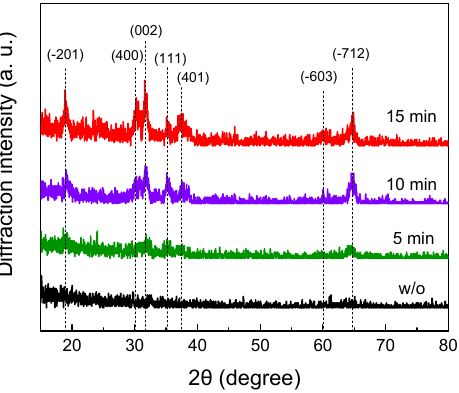
Figure 4. Grazing incidence in-plane XRD analysis of β -Ga 2 O 3 NTs oxidized at 950 °C and GaN NWs (w/o). Oxidation times and peak assignment are indicated in the figure.